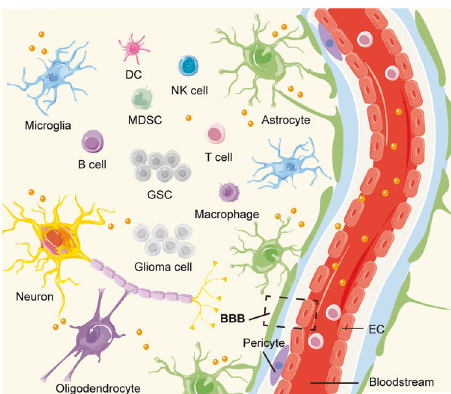
Fig. 3 GDEs and multiple cell types in glioma TME. There are many types of cells in the TME, roughly divided into four parts: (1) Tumor cells: glioma cell, GSC; (2) nerve cells: astrocyte, microglia, neuron, oligodendrocyte; (3) immune cells: macrophage, MDSC, DC, T cell, B cell, NK cell; (4) stroma cells: EC, pericyte. Especially, the GDEs mediate the intercellular communication in TME and can cross the BBB, which are expected to be novel targets for the treatment and diagnosis of glioma. GDE Glioma-derived exosome, TME tumor microenvironment, GSC glioma stem cell, MDSC myeloid-derived suppressor cell, DC dendritic cell, NK natural killer, EC endothelial cell, BBB blood-brain